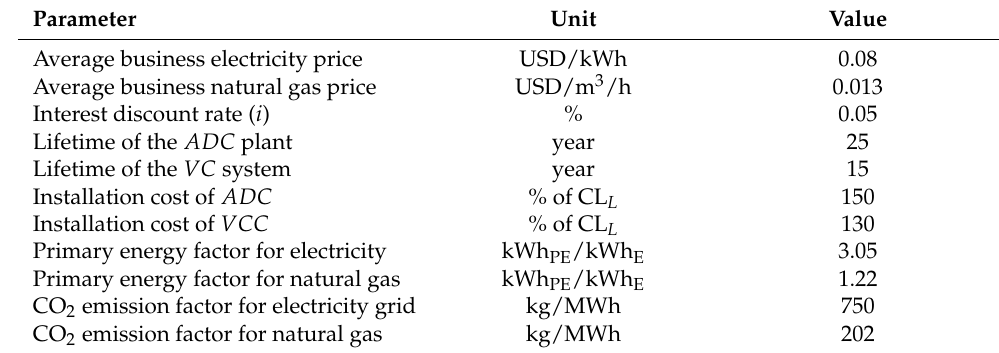
Table 3. Parameter values for the energy-related, economic and environmental (3E) analysis of the system. The values are extracted from the following references